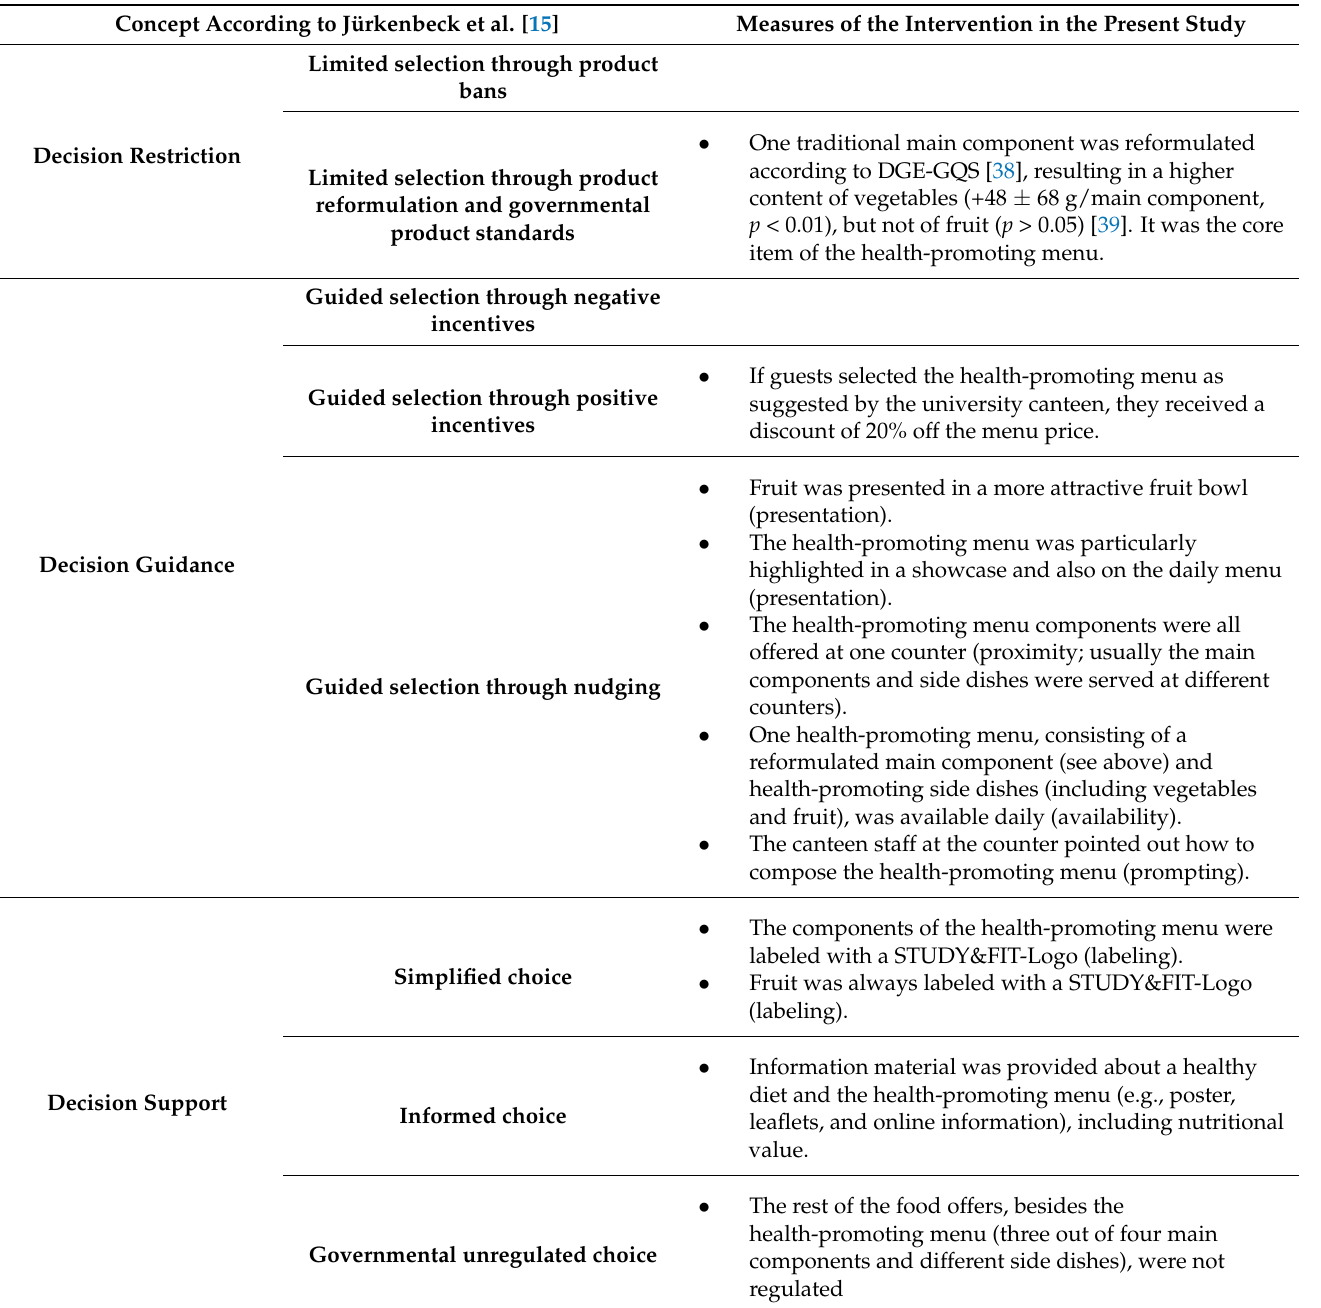
Table 1. Measures implemented in the present study according to Jürkenbeck et al.